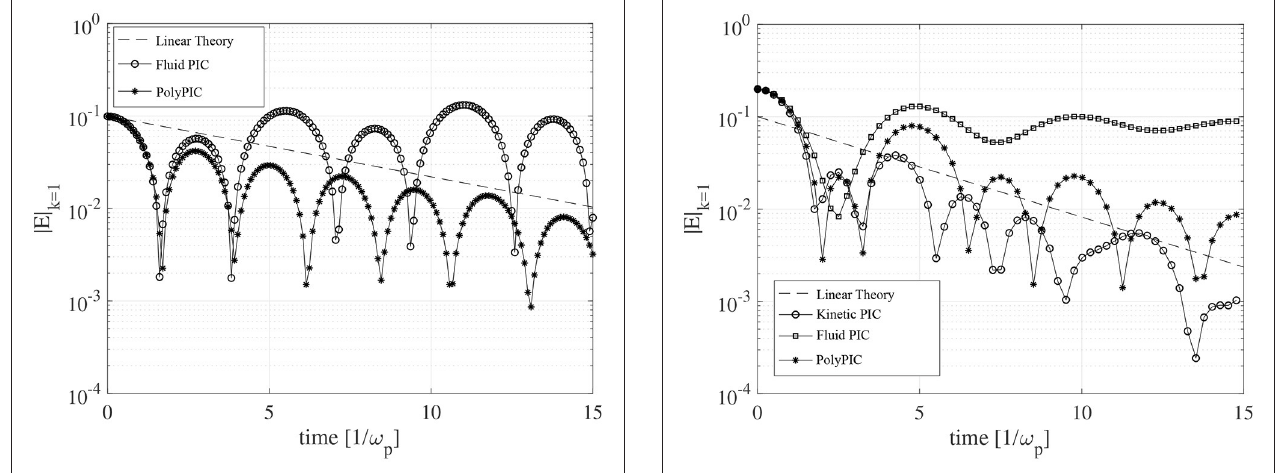
FIGURE 4 | Comparison between linear theory and PolyPIC simulation of Langmuir wave damping. The k 1 /3 D spectral component of the electric = field for the simulation with kinetic electrons and fluid ions (asterisks) decreases as predicted by the linear theory (dashed line). The fluid PIC simulation with both fluid electron and ions (open circles) do not show damping of the Langmuir wave.